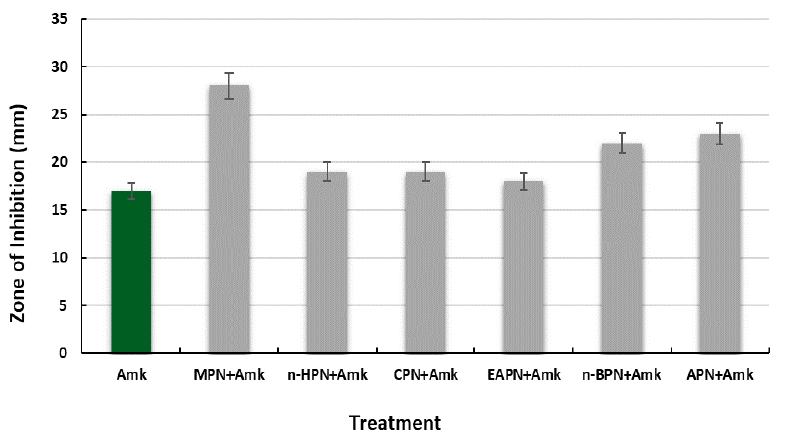
Figure 9. Antibiotic reversal activity of P. nigrum extracts in combination with amikacin (30 μg) for S. typhi.